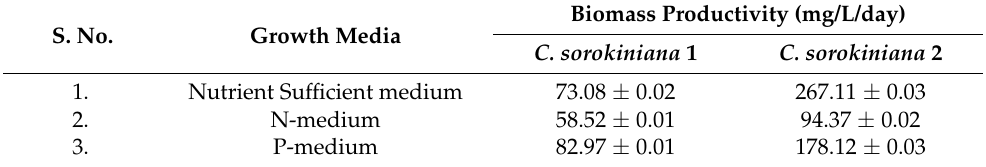
Table 5. Change in cell density of C. sorokiniana isolated from BG-11 and Knop’s media (pH-9) grown in synthetic hydrolysate growth medium with supplementation of N and P to accumulate a large amount of